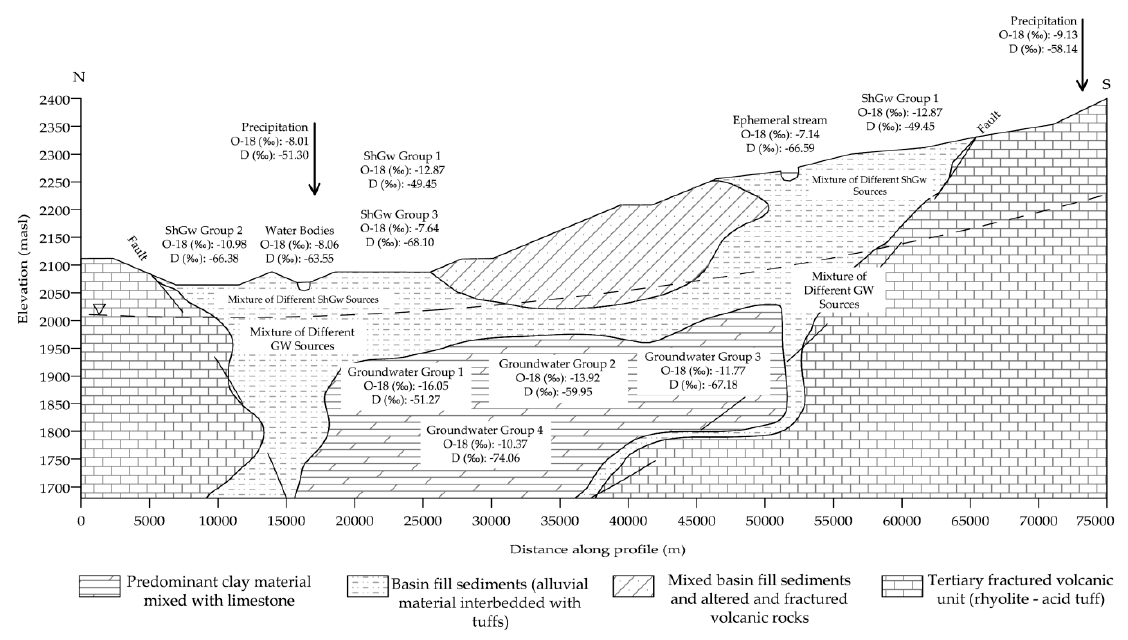
Figure 13. Conceptual diagram of recharge to the study area.